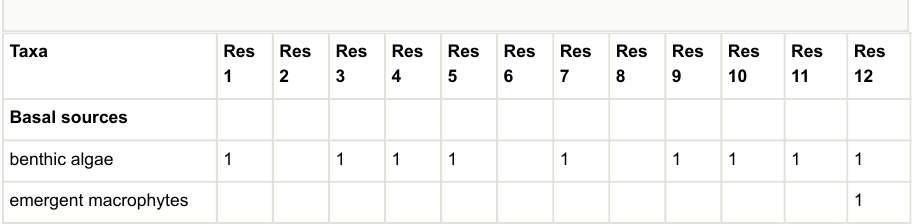
The records of all fish species and taxonomic groups included in the food webs across all 12 reservoirs, where "1" indicates that a taxon is